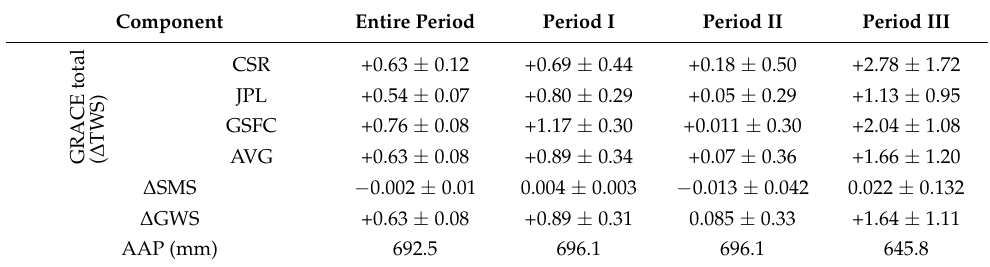
Table 1. GRACE-derived ∆ TWS components (cm/yr) over the study area at 95% confidence level. Component